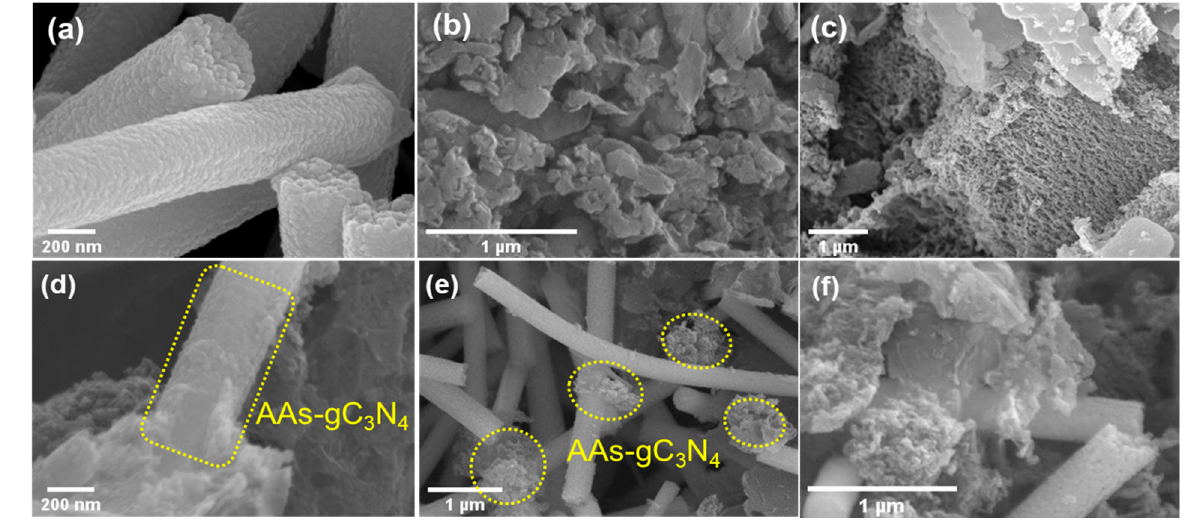
Figure 1. Field-emission scanning electron microscopy (FE-SEM) images of powder samples. ( a ) NiTiO 3 NFs, ( b ) bulk gC 3 N 4 , ( c ) AAs-gC 3 N 4 , ( d , e ) gnT6040, and ( f ) gnT4060.